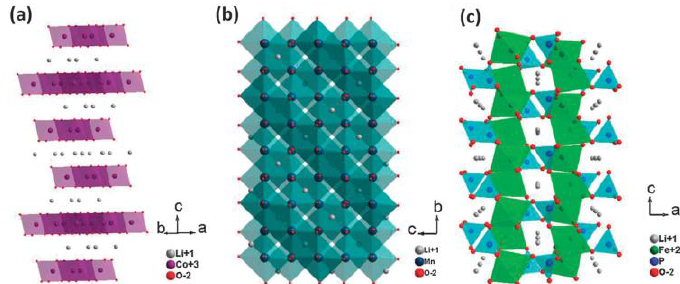
Figure 4. Schematic diagram of the crystal structures of three types of cathode materials for Li-ion batteries: ( a ) LiCoO 2 ; ( b ) LiMn 2 O 4 ; ( c ) LiFePO 4 .